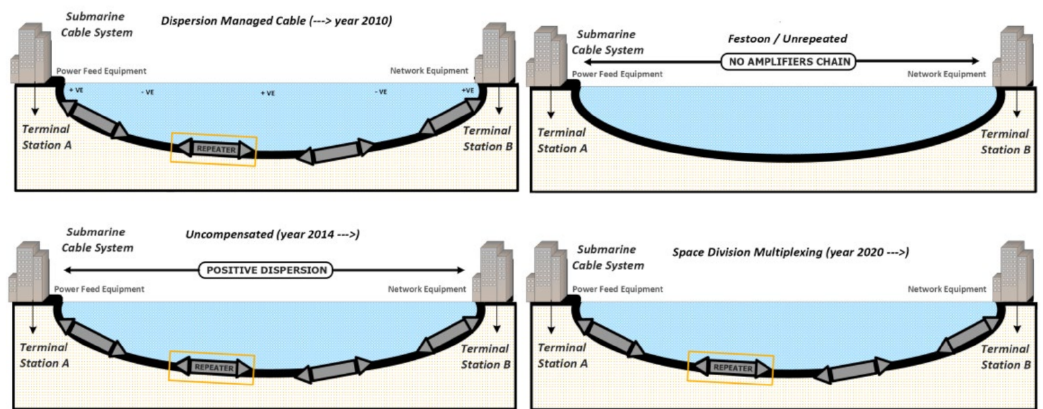
Figure 9. Types of submarine cables (e.g., SDM, festoon, uncompensated).